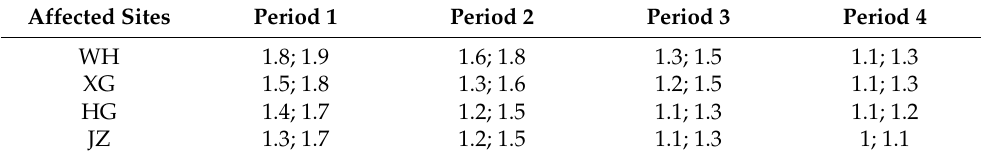
Table 8. Vulnerability and demand urgency coefficient of each affected site in each time period.